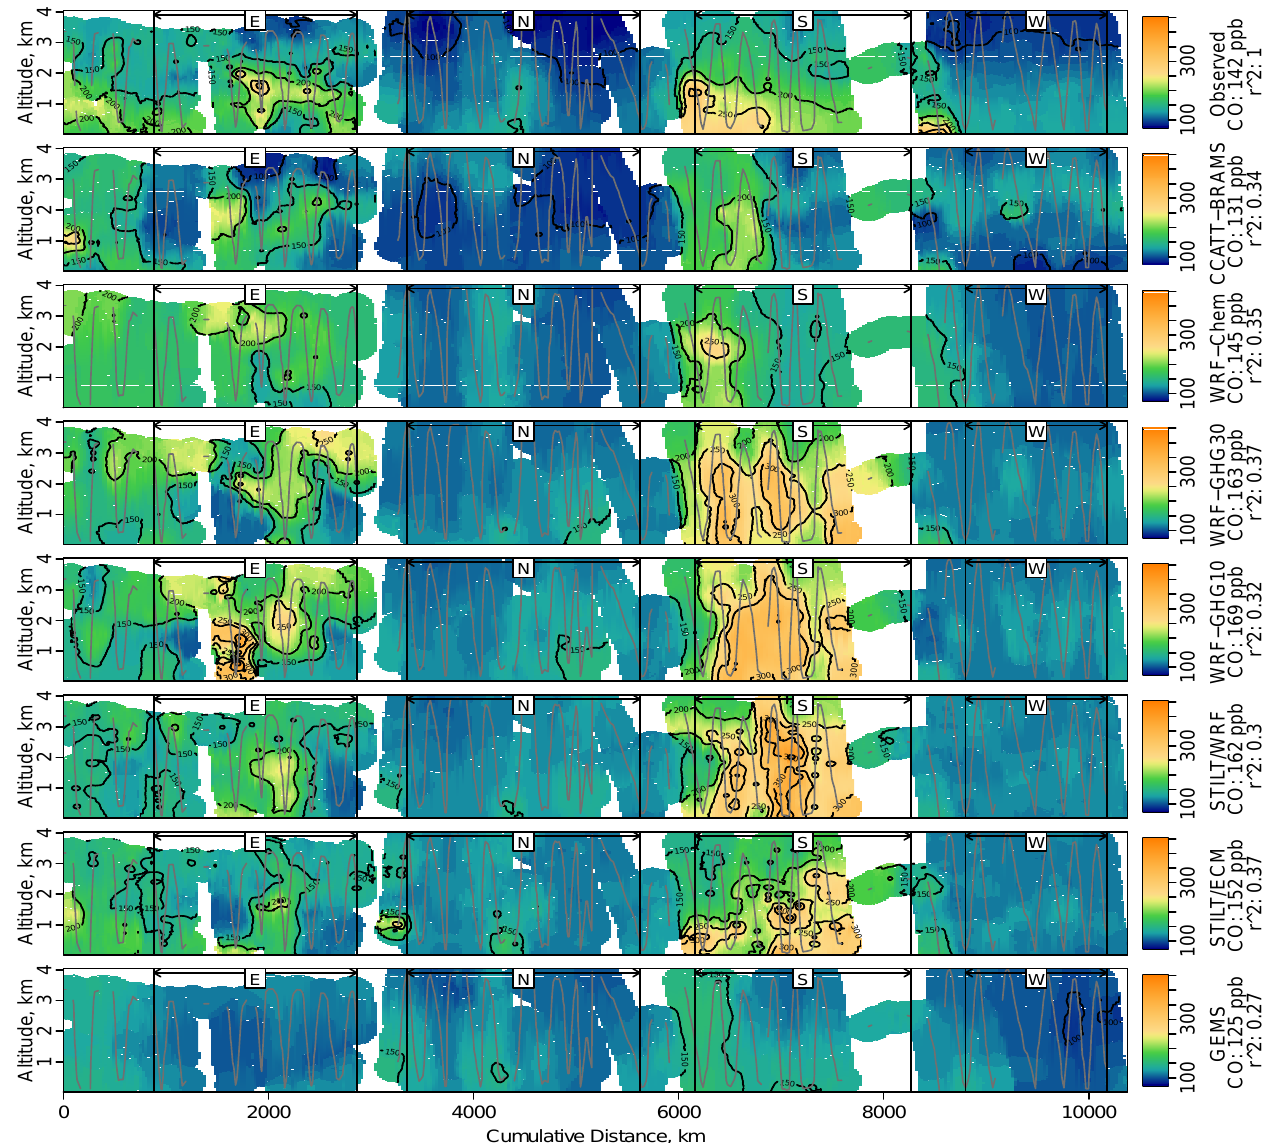
Fig. 11. Measured and modeled CO from various models along the flight track in units ofppb during BARCA-A. Shown are mixing ratios as function of altitude and cumulative distance flown by the aircraft, interpolated from the various vertical profile measurements using inverse distance weighting. From top to bottom: Observed CO, and modeled CO from CCATT-BRAMS, WRF-Chem, WRF-GHG (30km), WRF- GHG (10km), STILT-WRF, STILT-ECMWF, and from the GEMS-reanalysis. The different geographical parts (E, N, S, W) of the campaign are indicated at the top of each color plot; unmarked periods are within 200km of Manaus. Also shown to the right of the color legend are the averaged mixing ratios and the squared correlation coefficients between modeled and observed